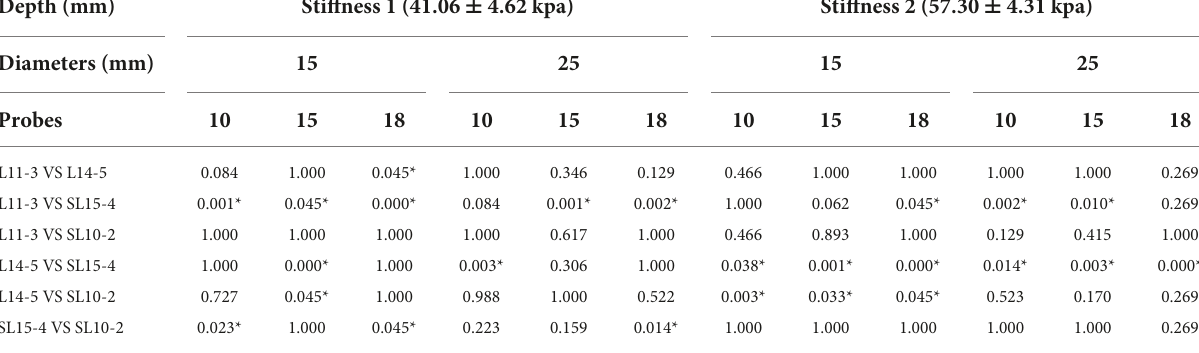
TABLE 2 Comparison of measurement values of different phantom subjects between four probes. Depth